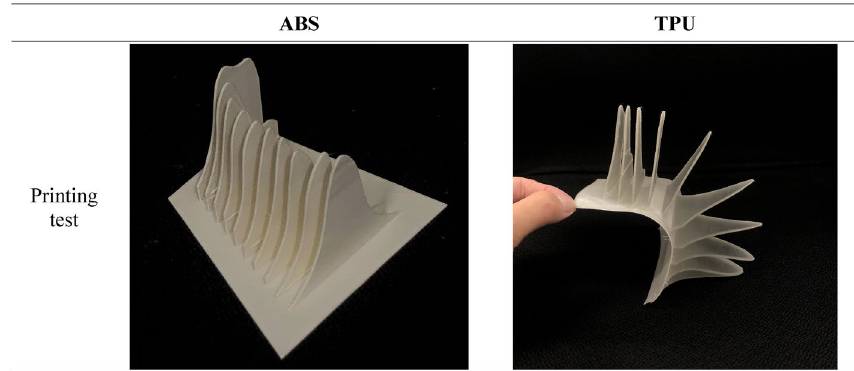
Table 6 Printing material tests for ‘Motif 2’